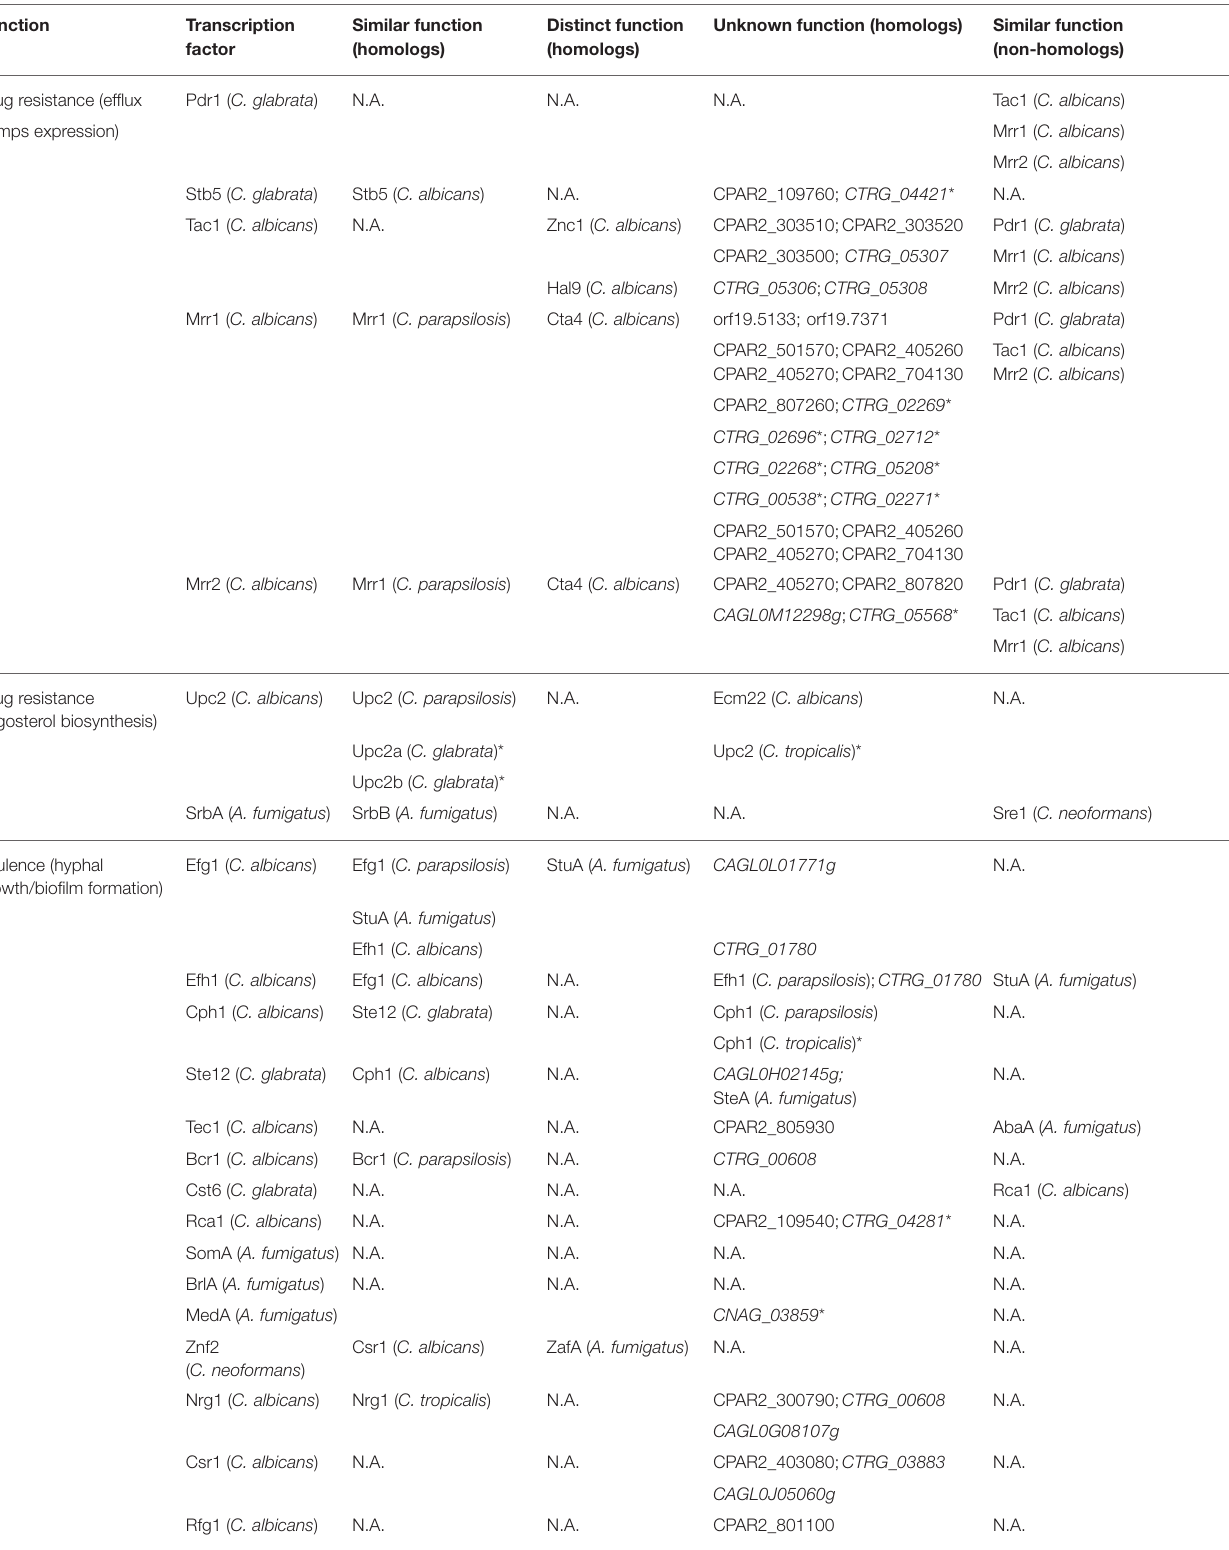
TABLE 1 | Conservation of function between described transcription factors in A. fumigatus , C. neoformans and Candida spp. and their correspondent homologs predicted by the Phylome DB.